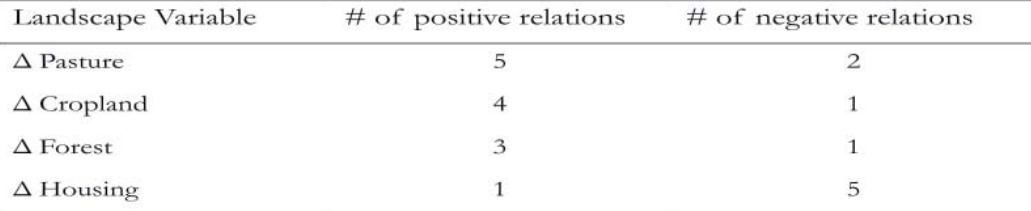
Table 2. Summary of bird relations with landscape change